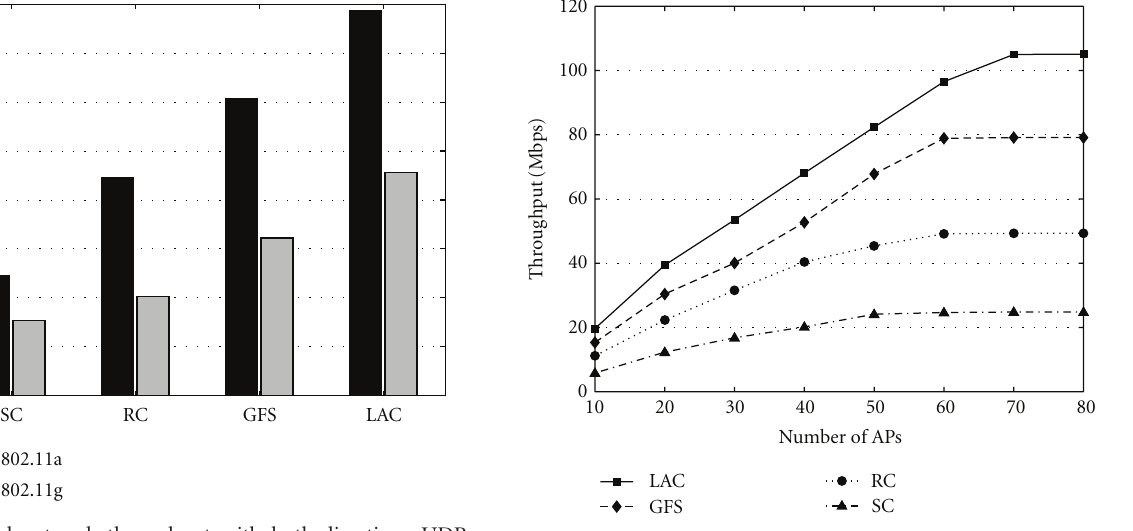
Figure 4: Total network throughput versus number of